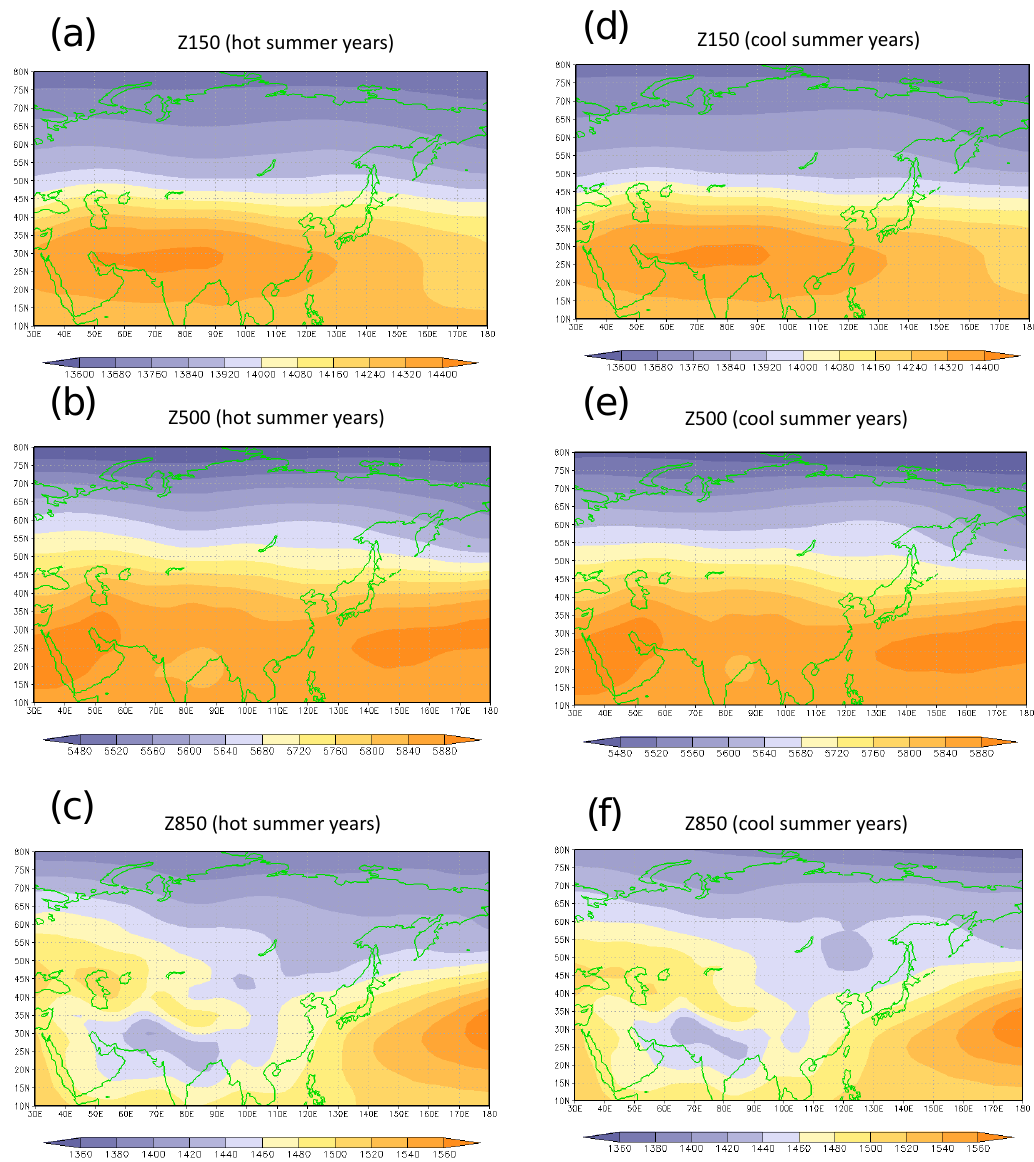
Figure 3. Spatial distribution of geopotential height (in m) at ( a , d ) 150 hPa, ( b , e ) 500 hPa, and ( c , f ) 850 hPa for hot summer years (10 years) and cool summer years (10 years), respectively, in the Sea of Japan side of Northern Japan (NJJ).